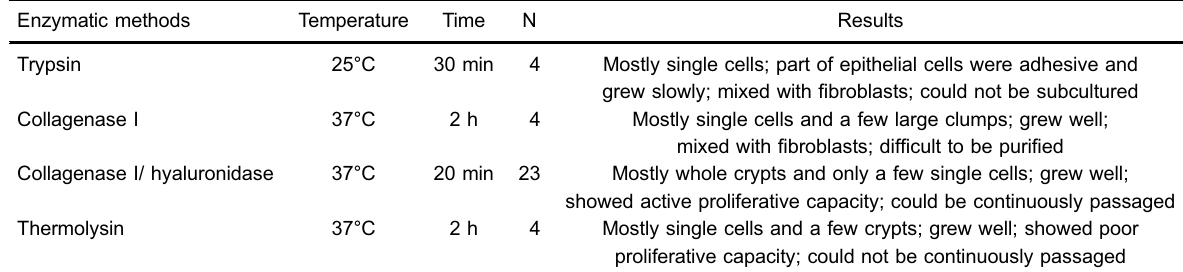
Table 2. Effect of different enzymatic methods on isolated mouse intestinal epithelial cells. Enzymatic